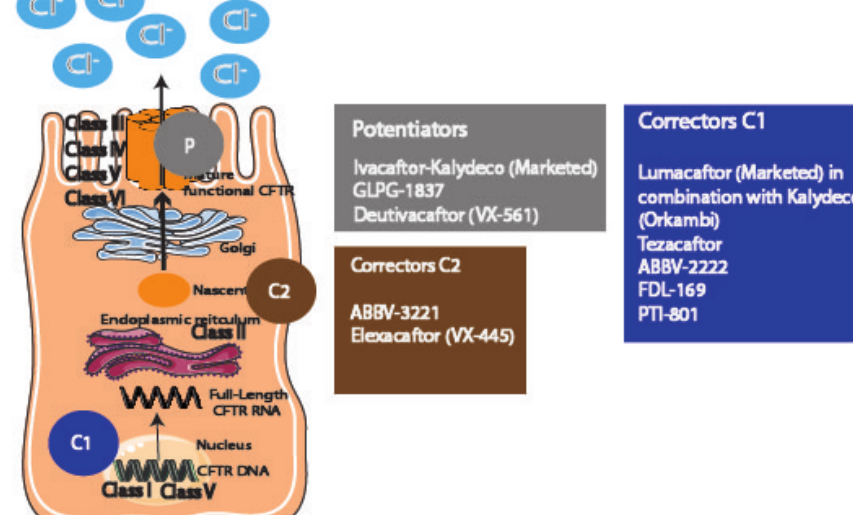
Figure 2. Di ff erent CFTR modulators and their targets. Abnormal CFTR protein biosynthesis /